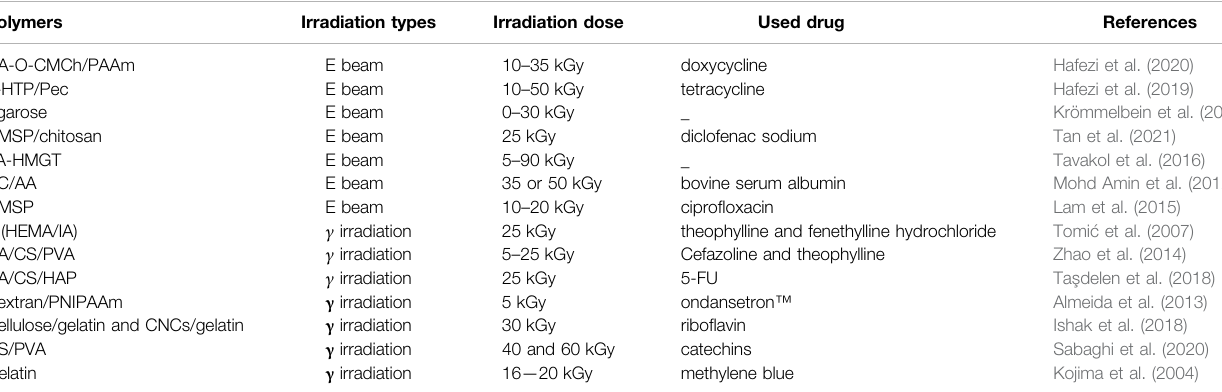
TABLE 1 | Depicting irradiation crosslinked polymers, irradiation types and dose, and used drugs.